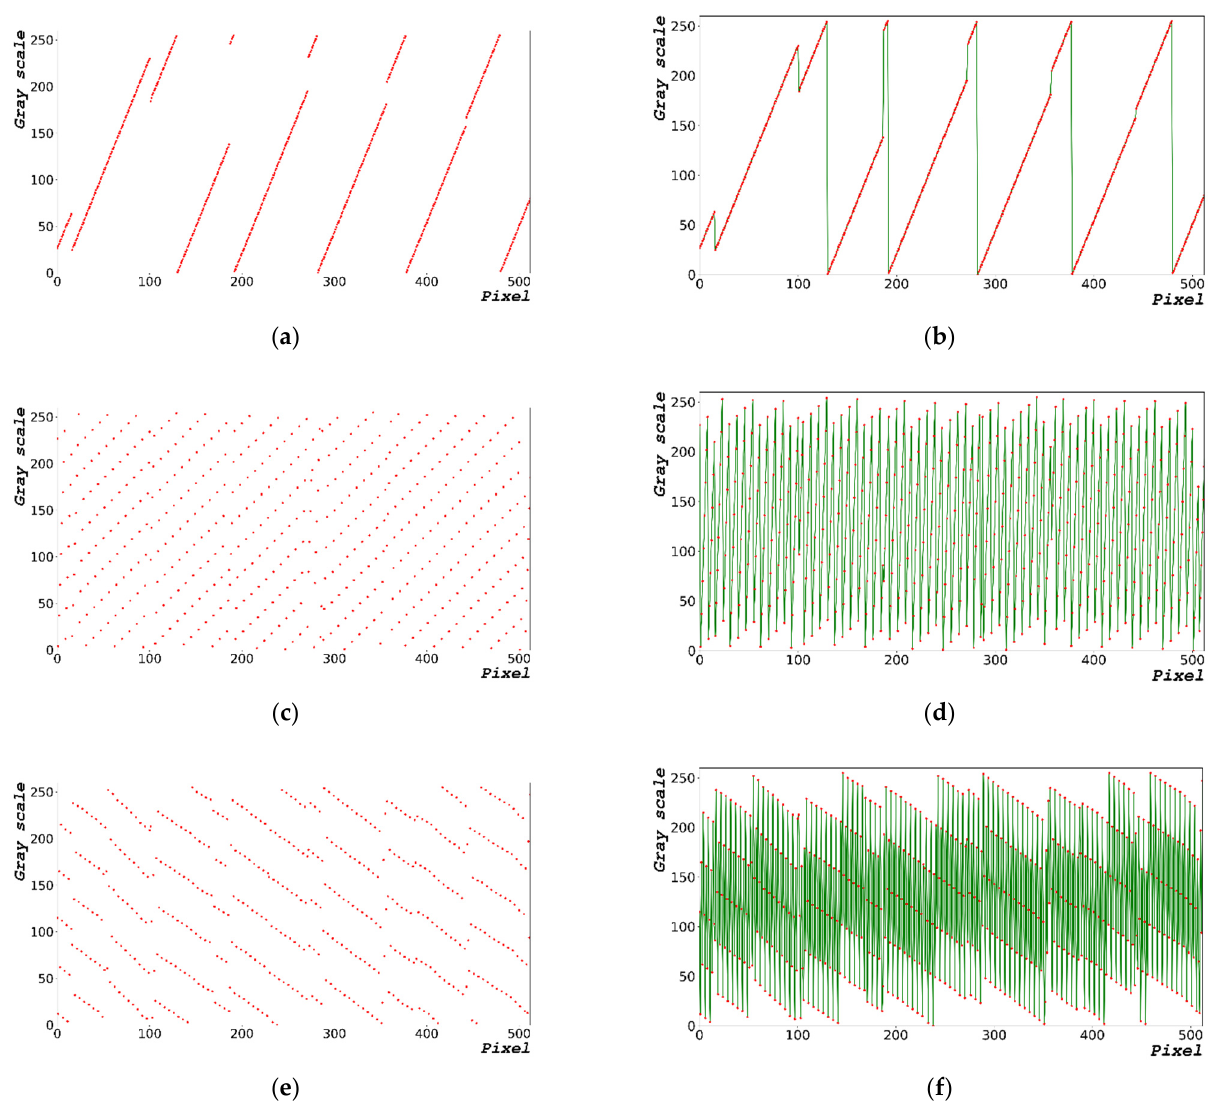
Figure 2. Random-bit generation result based on time: ( a ) 1000 × 663 random-bit generation time-series data; ( b ) generated random-bit trend line for dt = 0 μ s; ( c ) 1000 × 663 random-bit generation time-series data; ( d ) generated random-bit trend line for dt = 1.0 μ s; ( e ) 1000 × 663 random-bit generation time-series data; and ( f ) generated random-bit trend line for dt = 5.0 μ s. Red dot and green line represent the distribution and time flow of the random-bit, respectively.